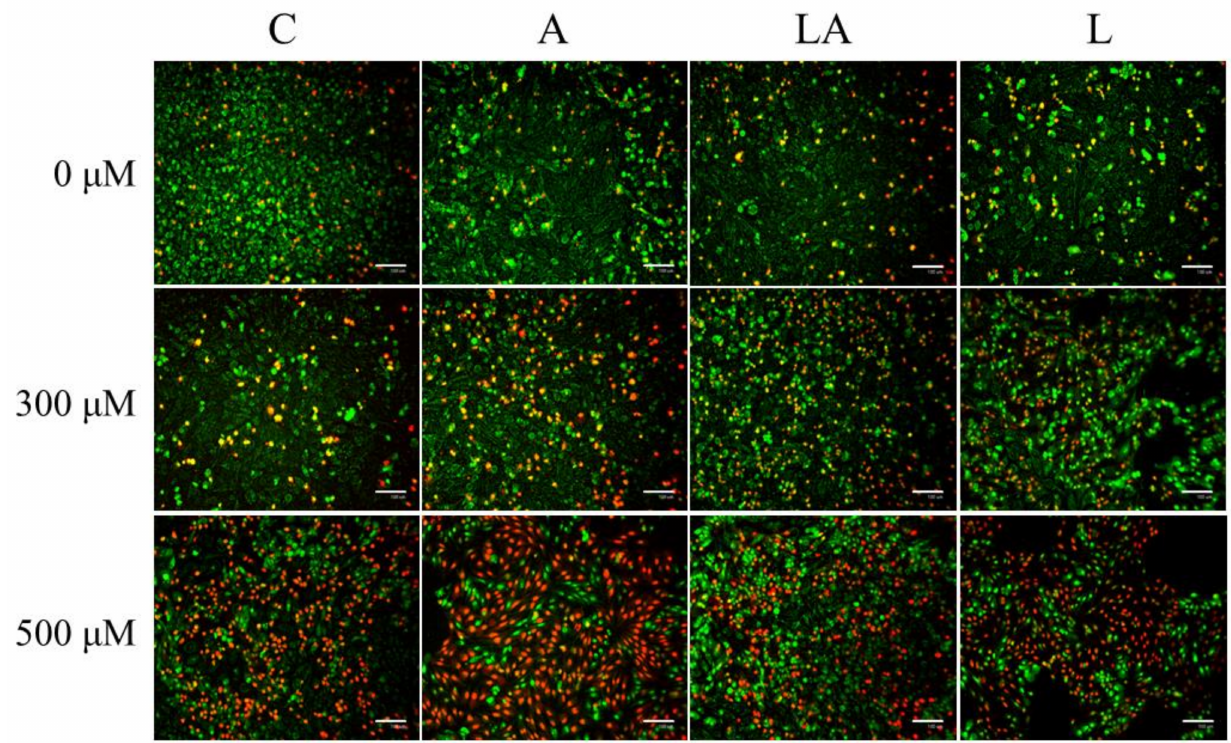
Figure A3. Live/dead staining of the cells treated with hydrogen peroxide. HeLa cells were cultured in experimental media for 72 h and treated with indicated concentrations of hydrogen peroxide. Total cells were stained with SYTO-9 (green), dead cells were stained with propidium iodide (red). C, control; A, acidosis; LA, lactic acidosis; L, high